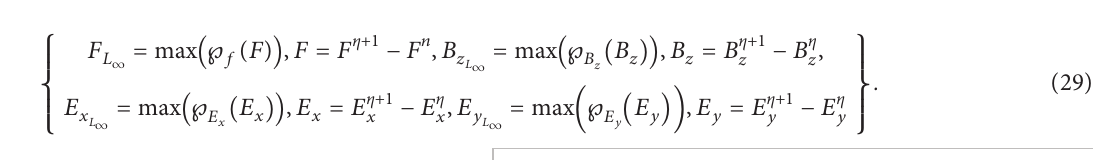
� M � M � M � 5 1 2 3 4